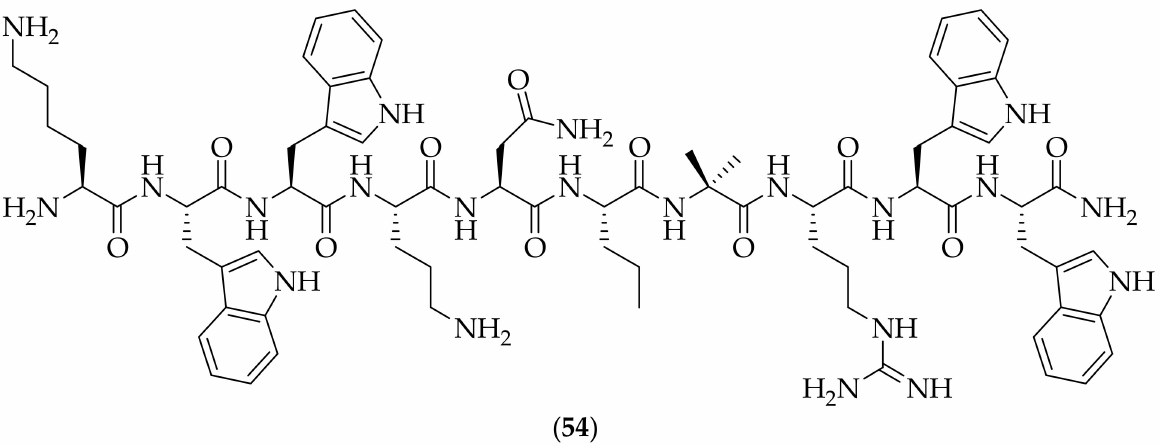
Figure 35. Optimized antifungal polypeptide K-oLBF127 ( 54